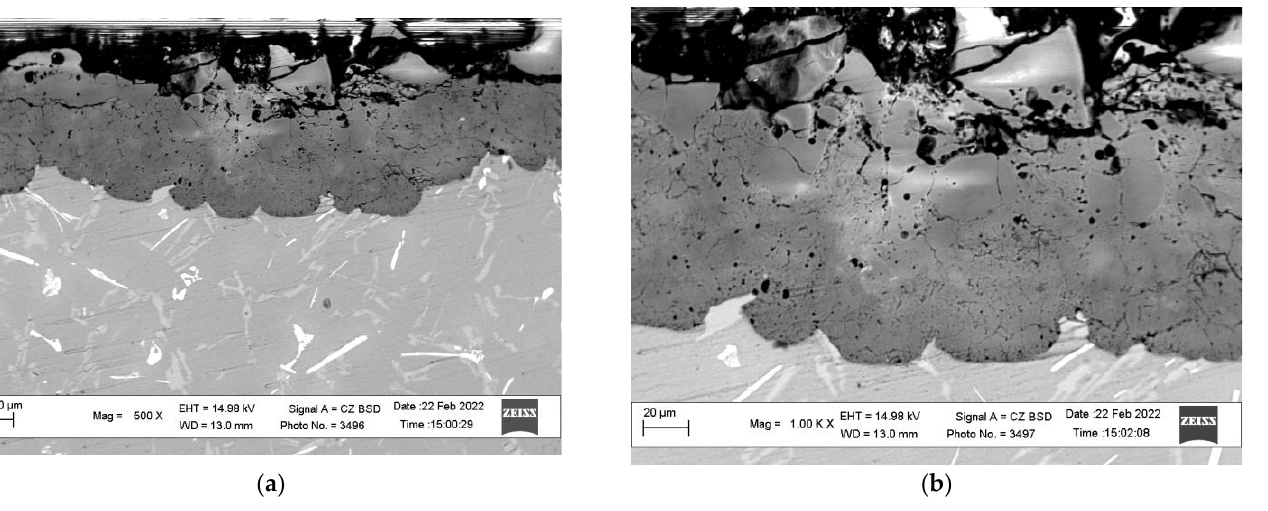
Figure 4. Structure of the PEO layer synthesized on the AK9 alloy in a weakly alkaline basic electrolyte (3 g/L KOH + 2 g/L Na 2 SiO 3 ), shown at low ( a ) and higher ( b ) (instead different) resolutions.